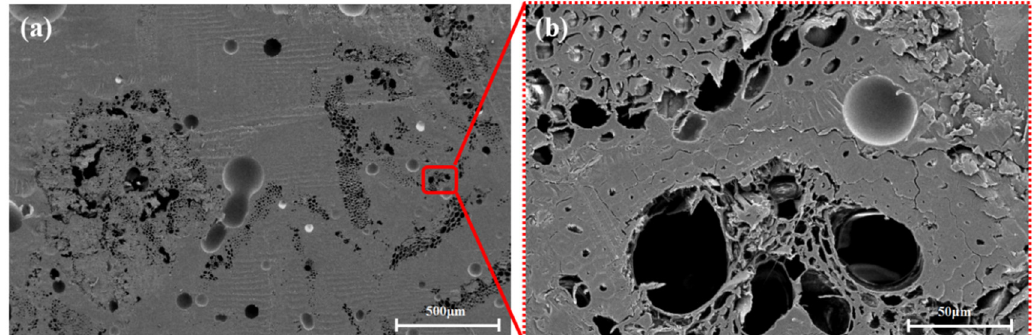
Figure 4. Microscopic morphology of cross-section of TBF-NOL: ( a ), 50×; ( b ), 500×.